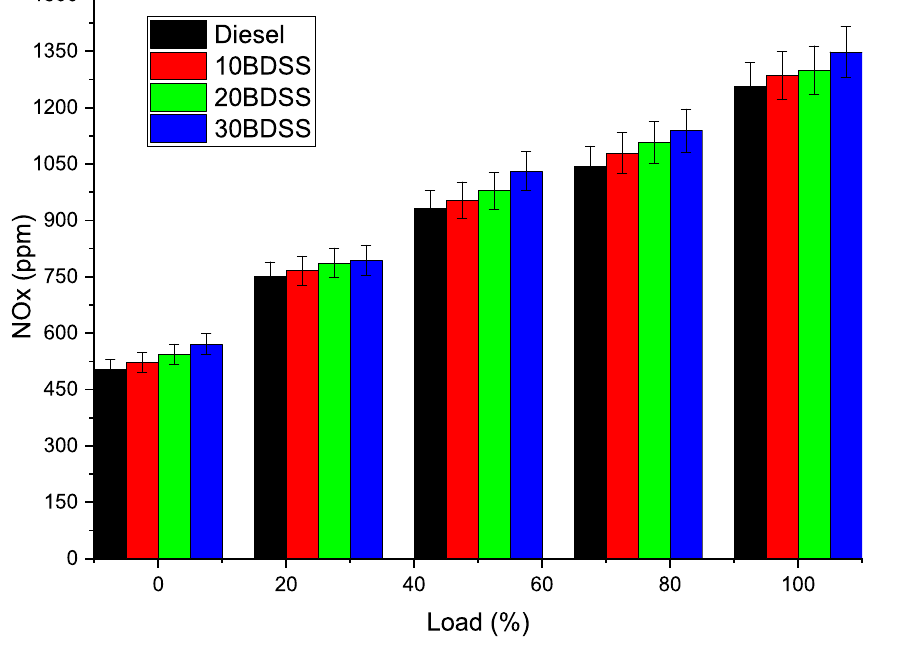
Figure 7. Influence of biodiesel blends in NOx emissions.